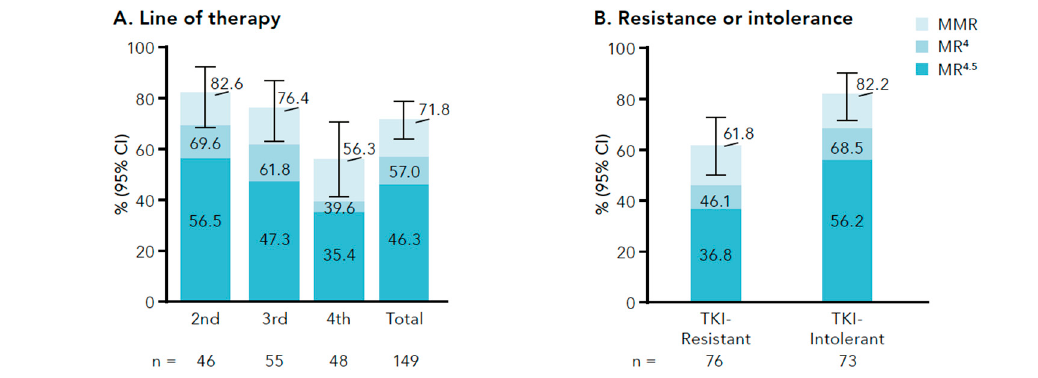
the BYOND study by ( A ) line of therapy and ( B ) resistance or intolerance to prior TKIs.